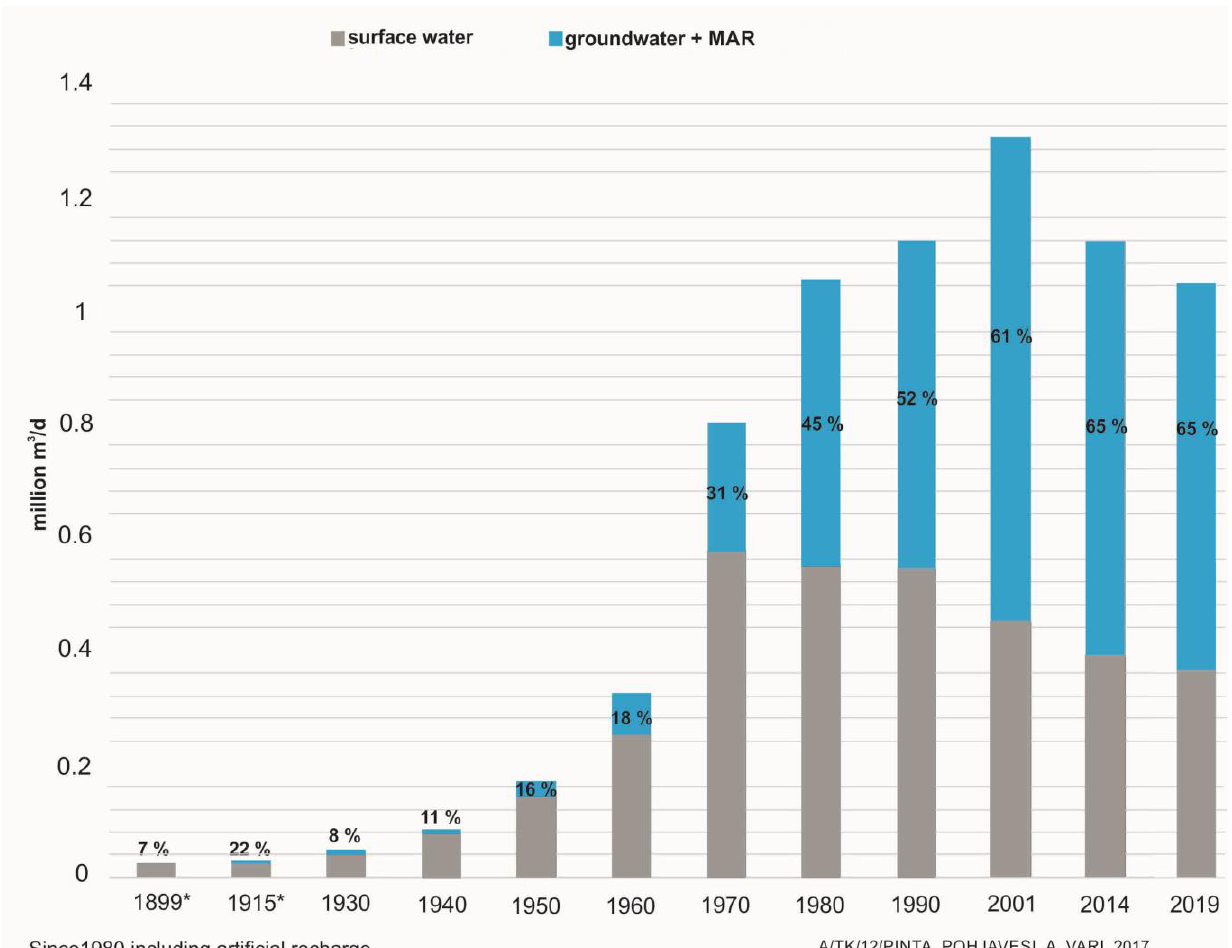
Figure 3. Changes in relative shares of surface and groundwater use of the total pumped volume by water utilities in Finland, 1899–2019 ([29] p. 63,